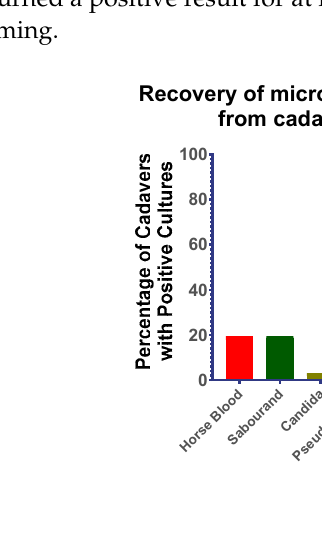
Figure 2. Growth of different samples on different agar plates. The numbers show the number of plates with growth for each patient, regardless of sample type. n = 35 for pre-embalming ( A ) and n